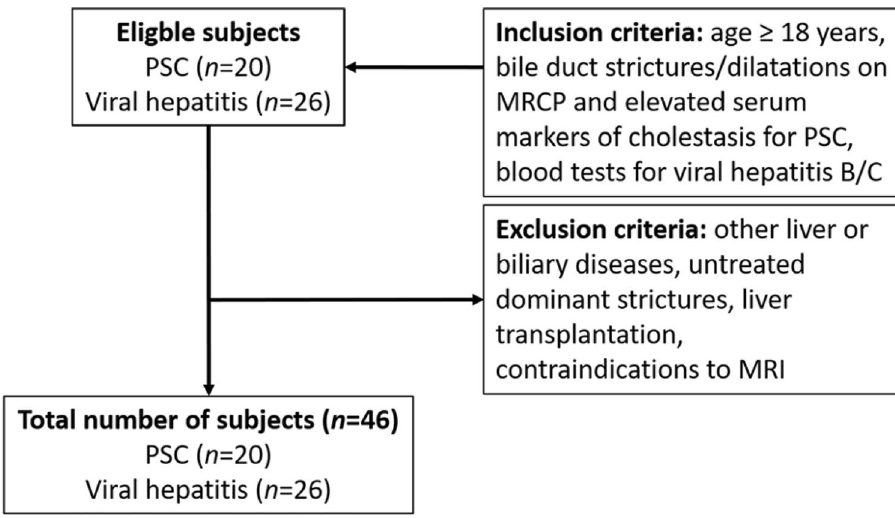
Figure 1. Flowchart of subjects. PSC primary sclerosing cholangitis, MRCP magnetic resonance